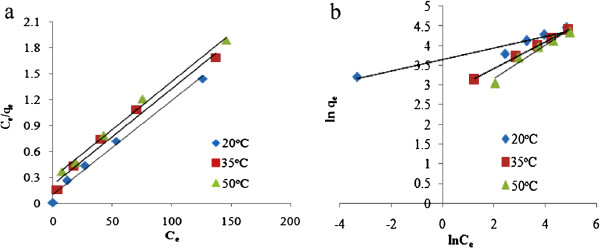
Langmuir (a) and Freundlich (b) models for aniline adsorption on AC-Fe3O4 MNPS.